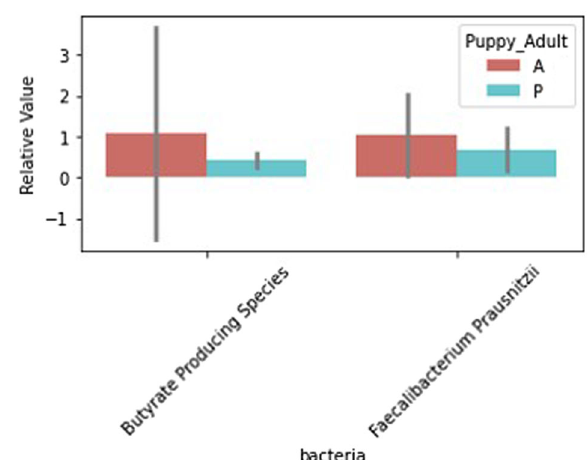
Fig. 1 Relative abundance of microbiome features that differed by the age group (adult (A) vs puppy (P)) of working canines and are statistically signi fi cant (only associations signi fi cant via Mann – Whitney test, p < 0.05, are included). Error bars represent con fi dence intervals.